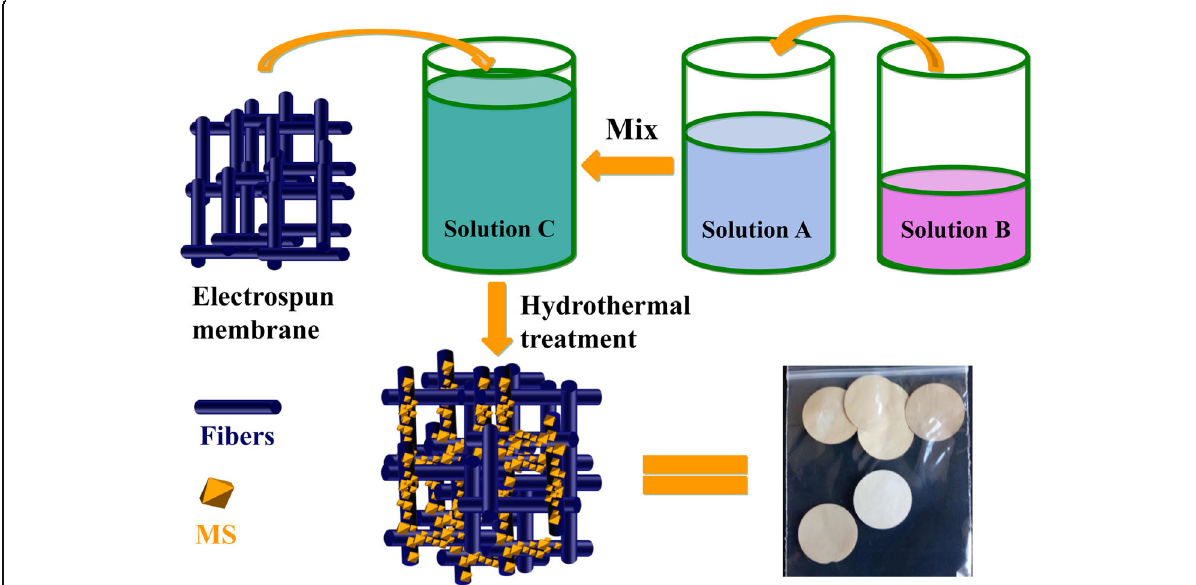
Fig. 1 Schematic illustration of the fabrication of MS@PVDF-HFP@PAN. The obtained electrospun membrane immersing into the MS precursor solution can obtain the MS@PVDF-HFP@PAN by hydrothermal